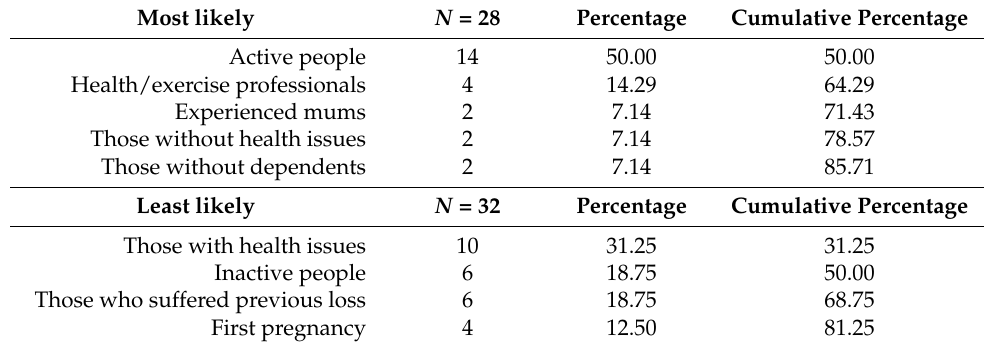
Table 3. Modal salient descriptive normative referents of pregnant women in East